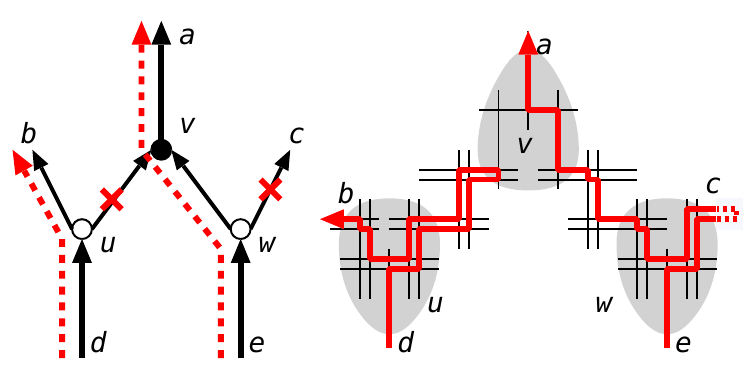
Figure 7. How to sweep thin